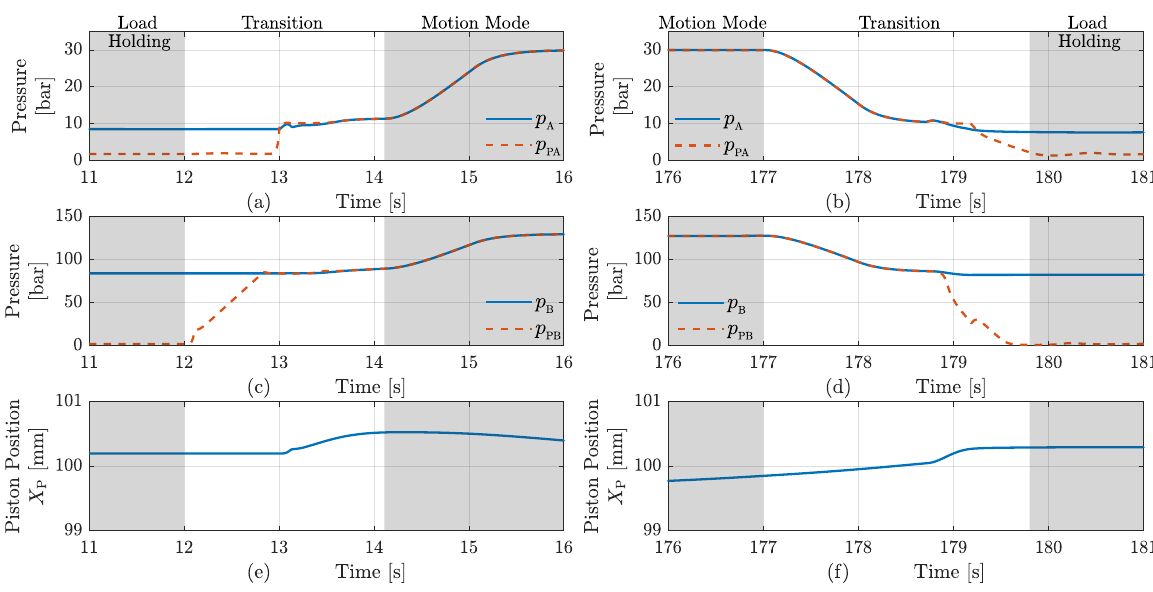
Figure 20: Transition between operation modes. (a) P A and P PA in transition between load holding and motion operating mode; (b) P A and P PA in transition between motion operating and load holding mode; (c) P B and P PB in transition between load holding and motion operating mode; (d) P B and P PB in transition between motion operating and load holding mode; (e) Piston position in transition between load holding and motion operating mode; (f) Piston position in transition between motion operating and load holding mode.